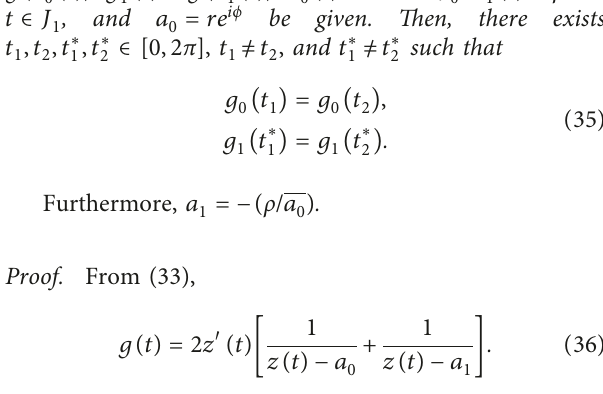
( t ) (bottom curve) for 1